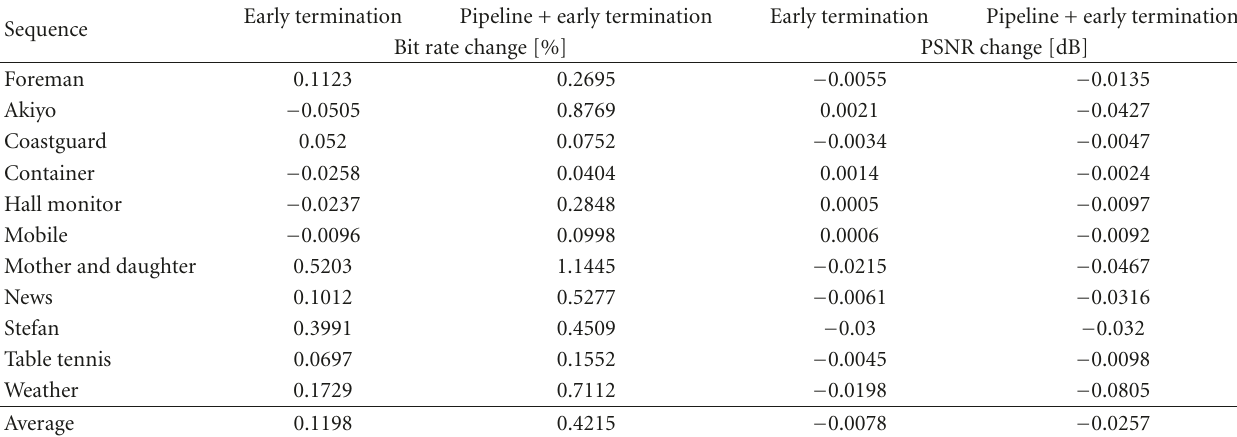
Table 7: Bit rate and PSNR change by pipeline and early termination in I and P